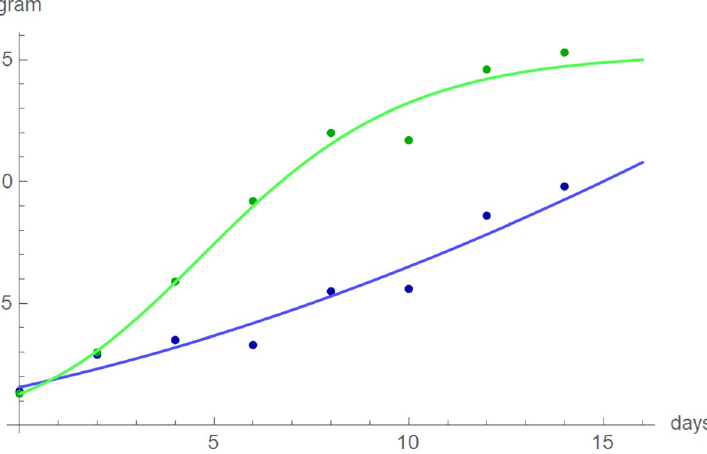
Fig 4. Mass and best-fitting BP-model growth curves of blue tit K7V3620 (blue) and great tit K7V3278 (green), chosen for their poor fits. (Days 1, 3, ... , and 15 correspond to t = 0, 1, ... , 14.).